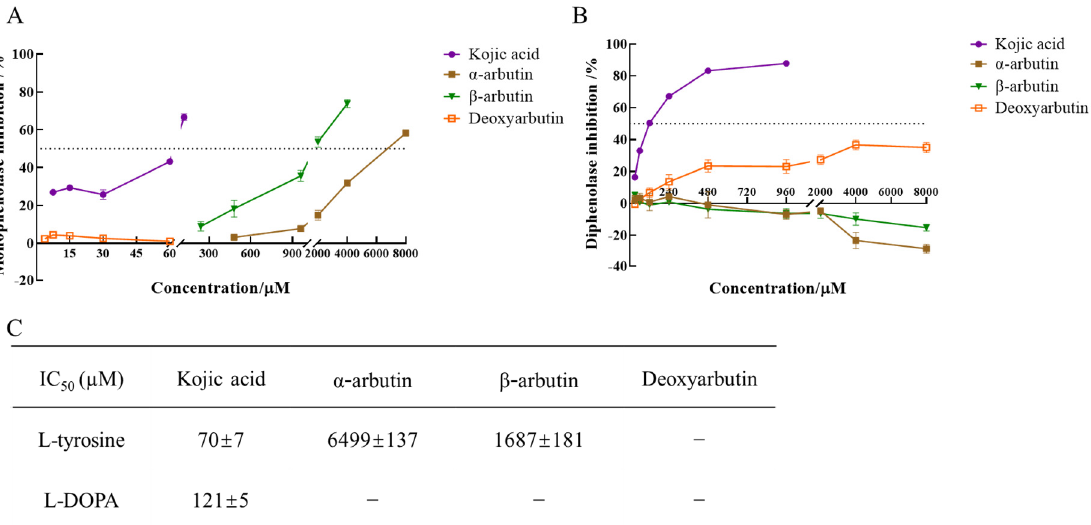
Figure 3. IC 50 value of kojic acid, α -arbutin, β -arbutin, and deoxyarbutin on monophenolase and diphenolase of MTYR. ( A ) Inhibition rate of monophenolase by compounds; ( B ) Inhibition rate of diphenolase by compounds; ( C ) IC 50 value of compounds on monophenolase and diphenolase. If the inhibition rate was negative, it meant the tyrosinase was activated. The activation rate was the absolute value of inhibition rate.